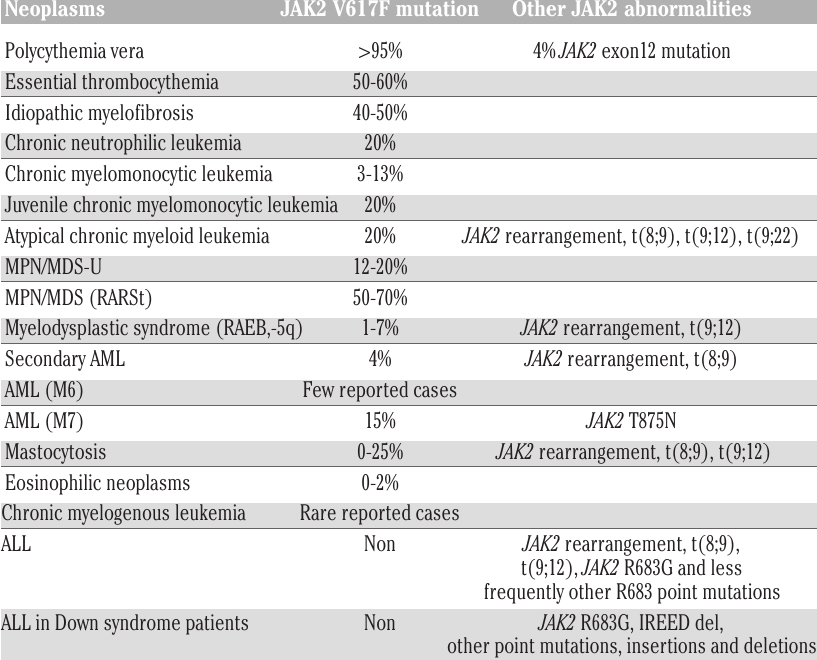
Table 1. Prevalence of JAK2 abnormalities in hematologic